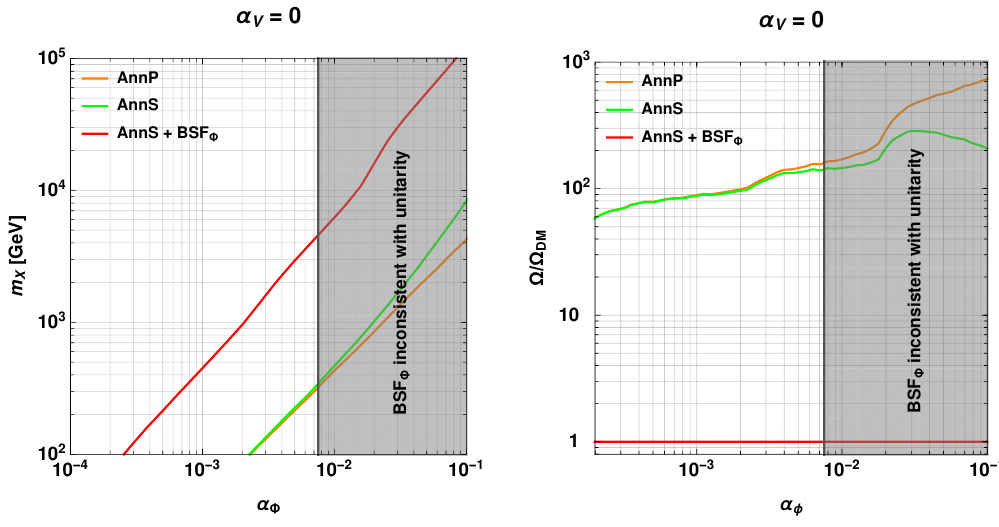
Figure 17 . In the limit of the local symmetry becoming global, (cid:11) between the DM mass m on the DM density ( right